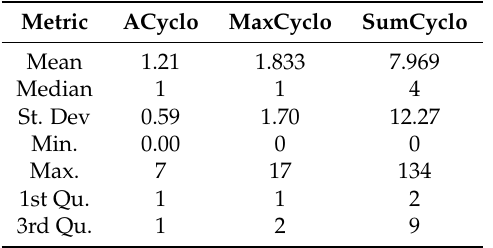
Table 5. Cyclomatic metrics computed in the solidity files belonging to Agile ICO projects. Metric ACyclo MaxCyclo SumCyclo